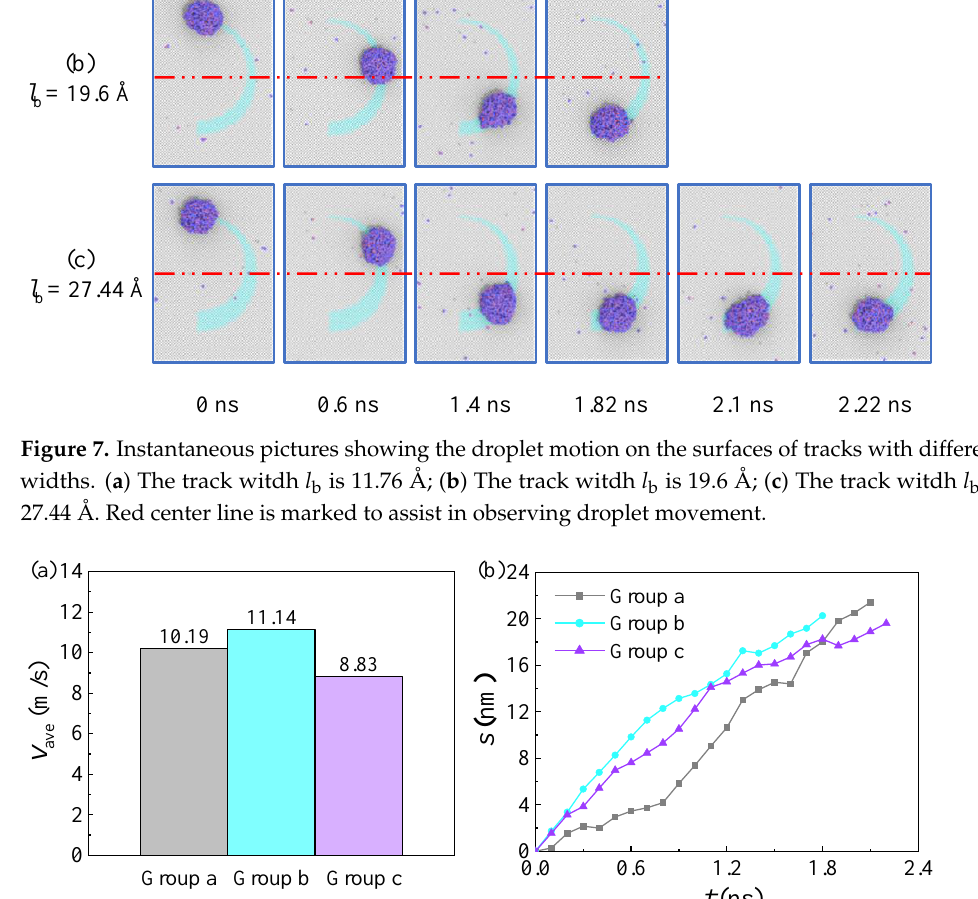
Figure 8. Influences of the track width: ( a ) Average motion velocities of the droplet correspond to different track widths. ( b ) Motion courses of the droplet over time correspond to different track widths.